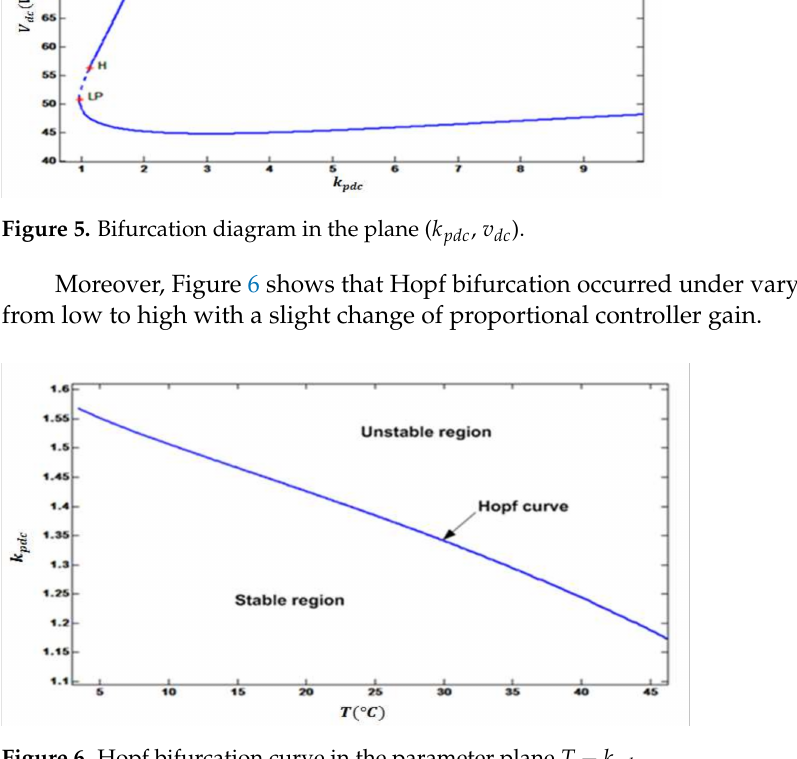
Figure 6. Hopf bifurcation curve in the parameter plane T − k pdc